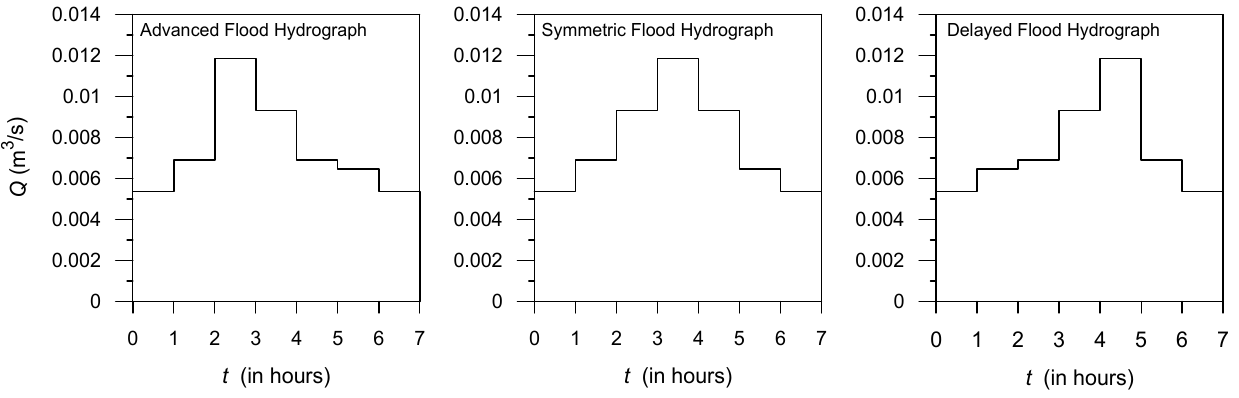
Figure 2. Three types of hydrographs used in this study.